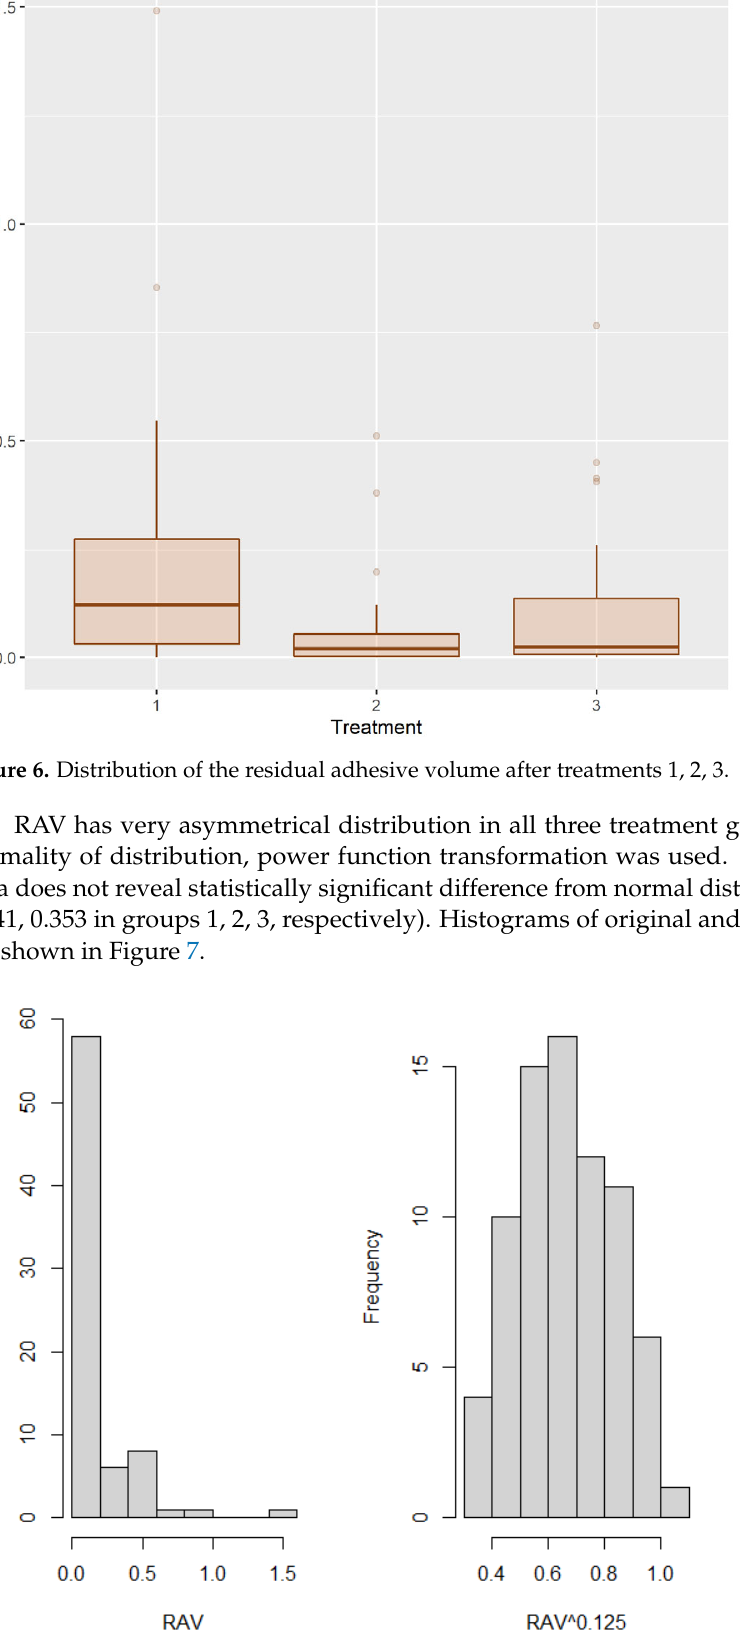
Figure 7. Histograms of RAV ( left ) and RAV 0.125 ( right ).